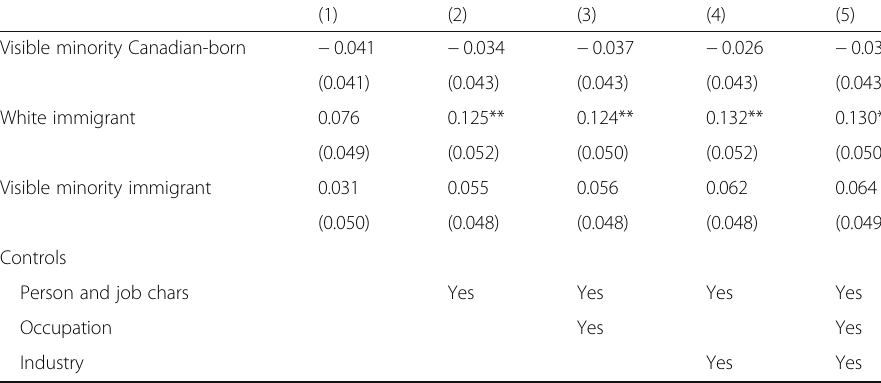
Table 9 Marginal effects from probit models of the probability of